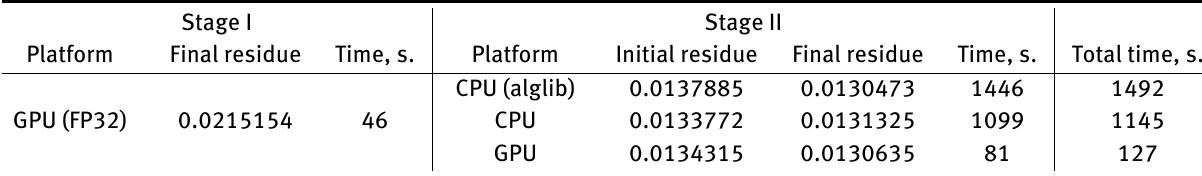
Table 5: Mixed-mode algorithm